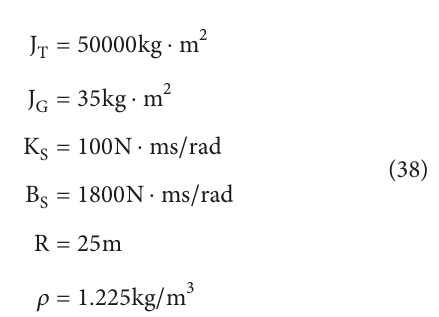
Figure 3. Given generator speed signal is square wave, as shown in Figure